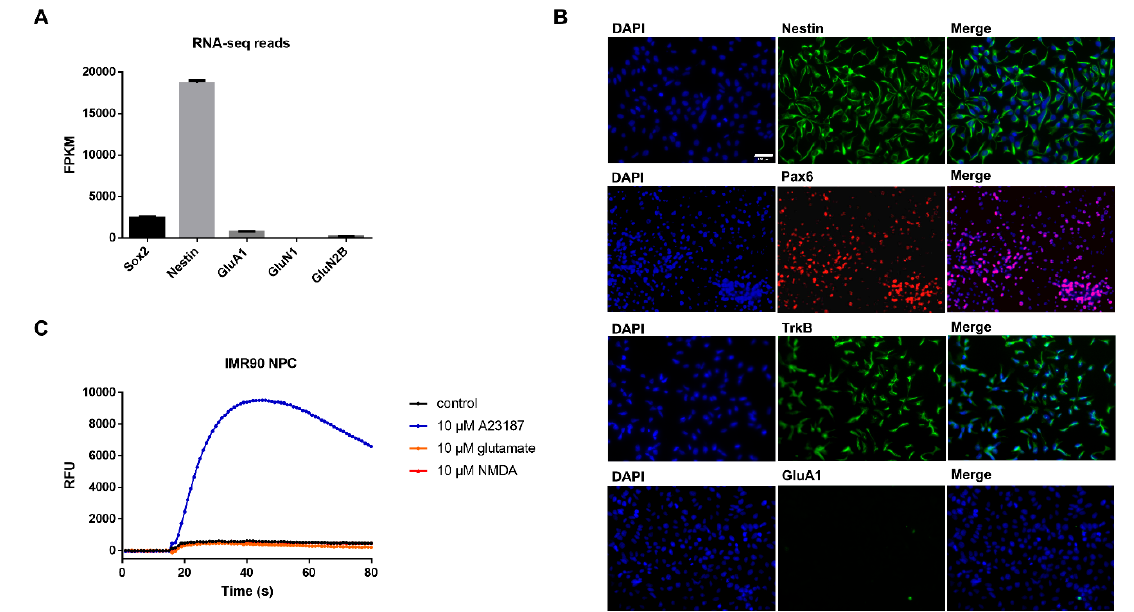
Figure 1. Characterization of human induced pluripotent stem cell-derived NPCs. ( A ) Read counts (fragments per kilobase of transcript per million mapped reads, FPKM) of RNA-seq analysis indicate mRNA expression of Sox2, Nestin, GluA1 (AMPA receptor subunit), GluN1 and GluN2B (NMDA receptor subunits). The data represent the means of three independent samples, and error bars were calculated using ± SEM. ( B ) Immunocytochemical characterization of iPSC-derived NPCs showing protein expression of the neuronal progenitor markers Nestin and Pax 6, and the BDNF receptor TrkB, but no expression of the ionotropic glutamate receptor AMPA-R (GluA1 subunit), scale = 100 µ m. ( C ) Functional analysis of NMDA-receptors in human iPSC-derived IMR90 NPCs using the Fluo-8 calcium mobilization assay. The calcium ionophore A23187 served as a positive control. No functional NMDA receptors are expressed in undi ff erentiated NPCs. Abbreviations: Sox2 (sex determining region Y)-box 2), GluA1 (glutamate ionotropic receptor AMPA type subunit 1), GluN1 (glutamate ionotropic receptor NMDA type subunit 1), GluN2B (glutamate ionotropic receptor NMDA type subunit 2B), Pax6 (paired box 6), BDNF (brain derived neurotrophic factor), TrkB (tropomyosin-related kinase